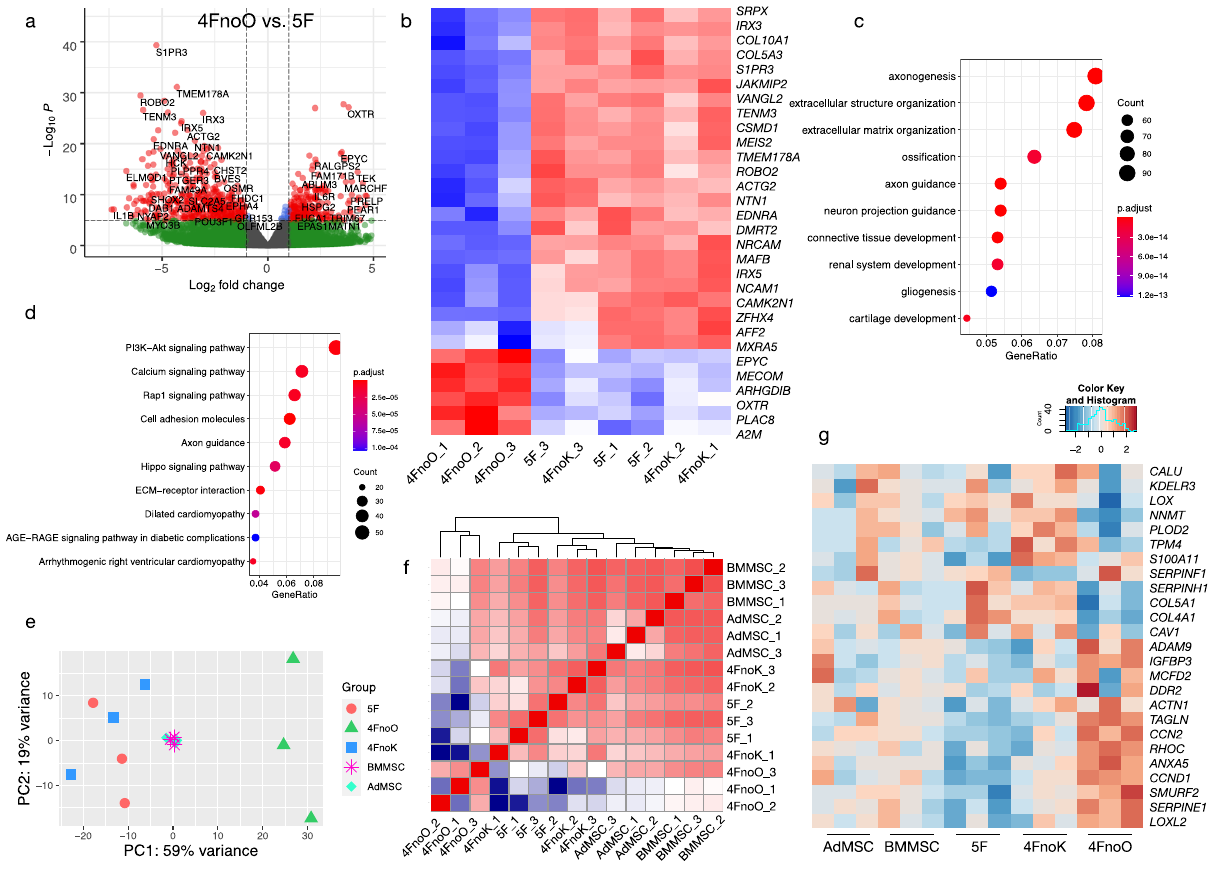
Fig. 4 Comparative transcriptome analysis of iMSCs reprogrammed from PBMCs. a Volcano plot showing differentially expressed genes identi fi ed in 4FnoO iMSCs compared with 5F iMSCs. Each dot represents a gene. The red dots are genes signi fi cantly upregulated (right) or downregulated (left) in 4FnoO iMSCs (Cutoff: P < 10e − 6 , fold change > 2). b Heatmap showing the top 30 differentially expressed genes between 5F iMSCs and 4FnoO iMSCs (ranked by p -value). c , d Dot plots showing the top Gene Ontology (GO) biological process (BP) terms ( c ) and KEGG pathways ( d ) enriched from DEGs in 4FnoO iMSCs compared to 5F iMSCs. e PCA of RNA-seq from iMSCs 4 weeks after reprogramming with 5F, 4FnoO, or 4FnoK, primary human bone marrow-derived MSCs (BMMSC) and primary adipose-derived MSCs (AdMSC). For each condition, iMSCs were reprogrammed from PBMCs derived from three biologically independent donors. f Pearson correlation analysis of iMSCs and primary MSCs. g Comparison of twenty-four genes previously determined to be speci fi c to the MSC lineage between primary MSCs and (PCA) (Fig. 4e). The reduction of the multi-dimensional dataset